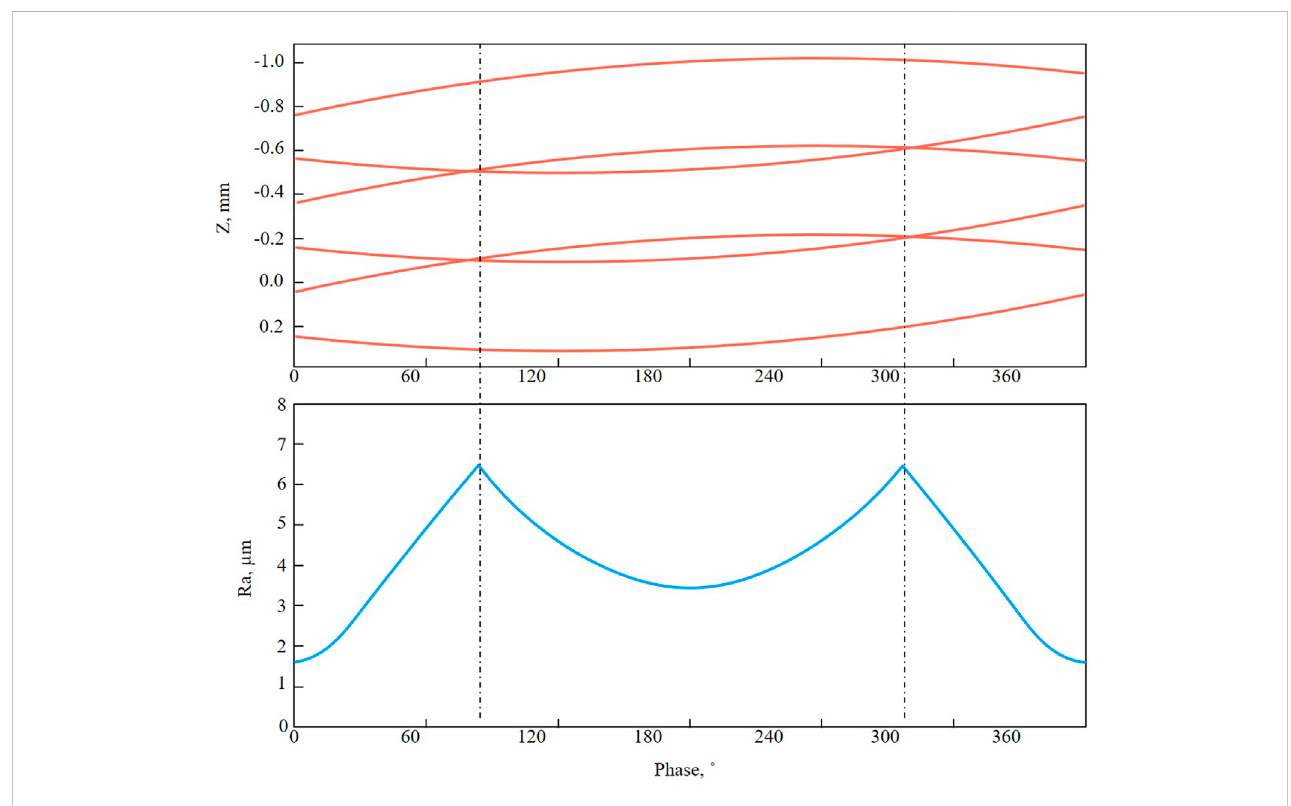
FIGURE 5 Path of the cutting edge and surface roughness in